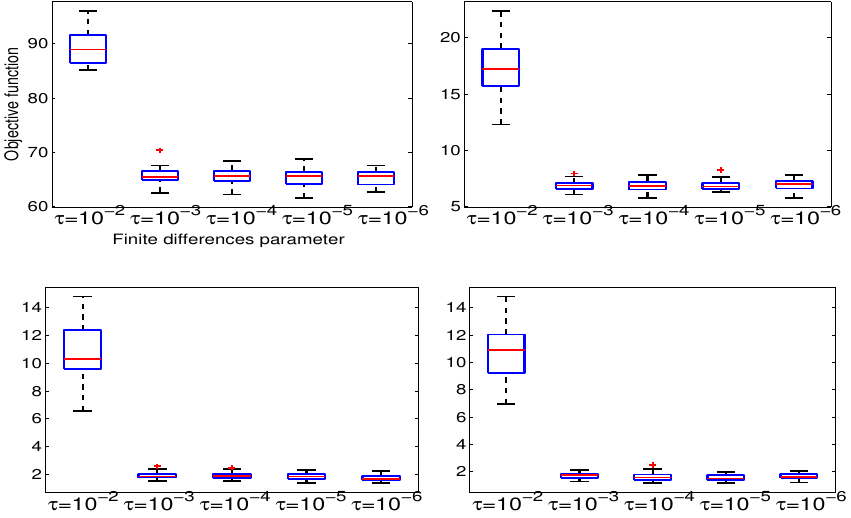
Figure 4. Same as Fig. 3, but for the fifth, sixth, seventh and eighth iteration, respectively.